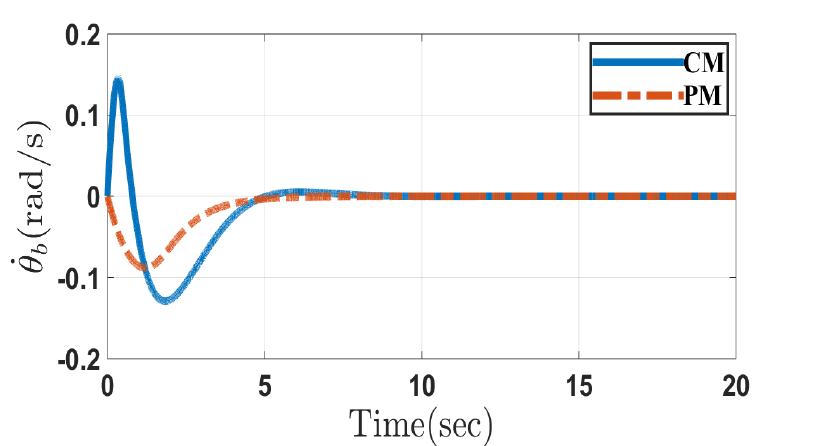
Figure 3. Pitch angular velocity of the system in the conventional method (CM) and the proposed method (PM) in Case 1.